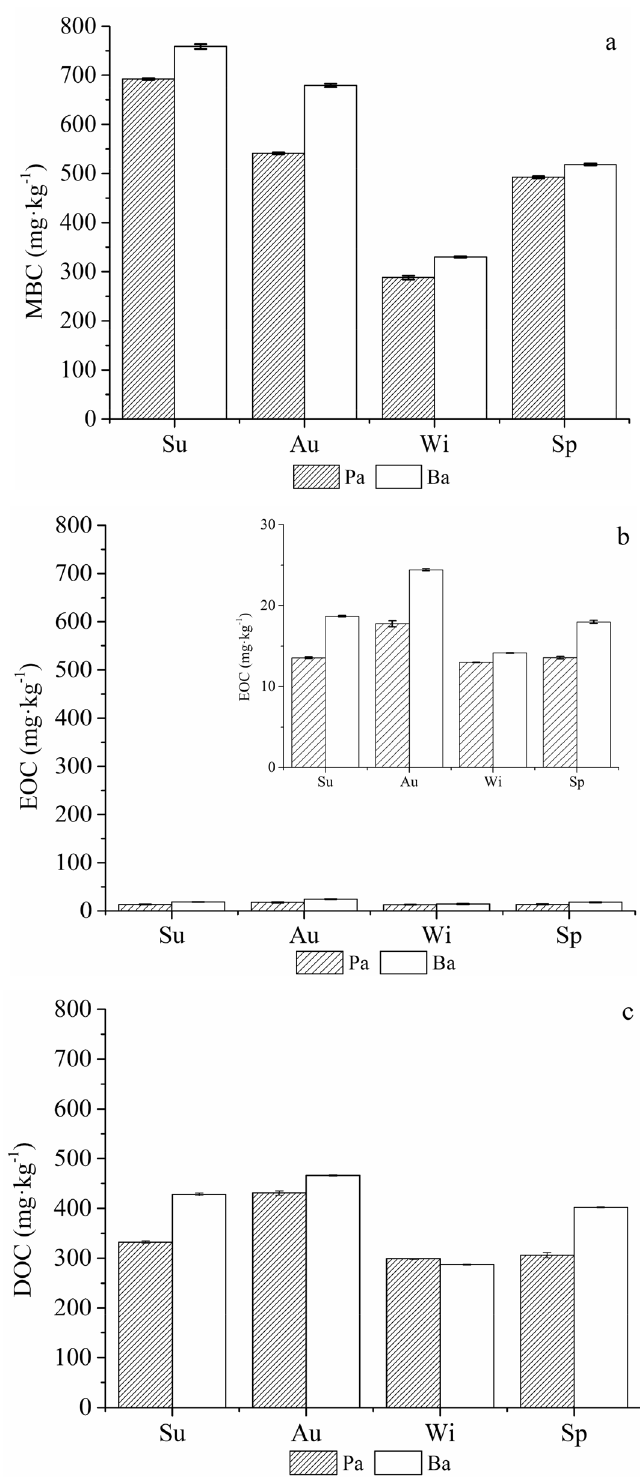
Figure 1. Changes in MBC ( a ), EOC ( b ) and DOC ( c ) in the four seasons. The error bars show standard errors. Sp, Su, Au and Wi represent spring, summer, autumn, and winter, respectively. Pa: Picea asperata Mast.; Ba: Betula albosinensis ; MBC: microbial biomass carbon, EOC: easily oxidized organic carbon; and DOC: dissolved organic carbon (this figure is created by Origin, version 9.0, 2012, OriginLab, Northampton, MA, USA; software available at: https ://www.origi